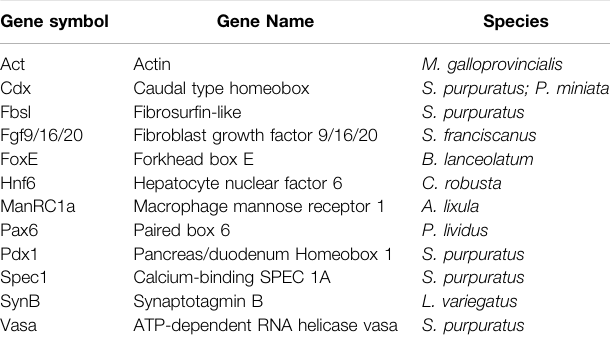
TABLE 1 | List of gene markers used to test uFISH protocol in mollusks, echinoderms, tunicates and